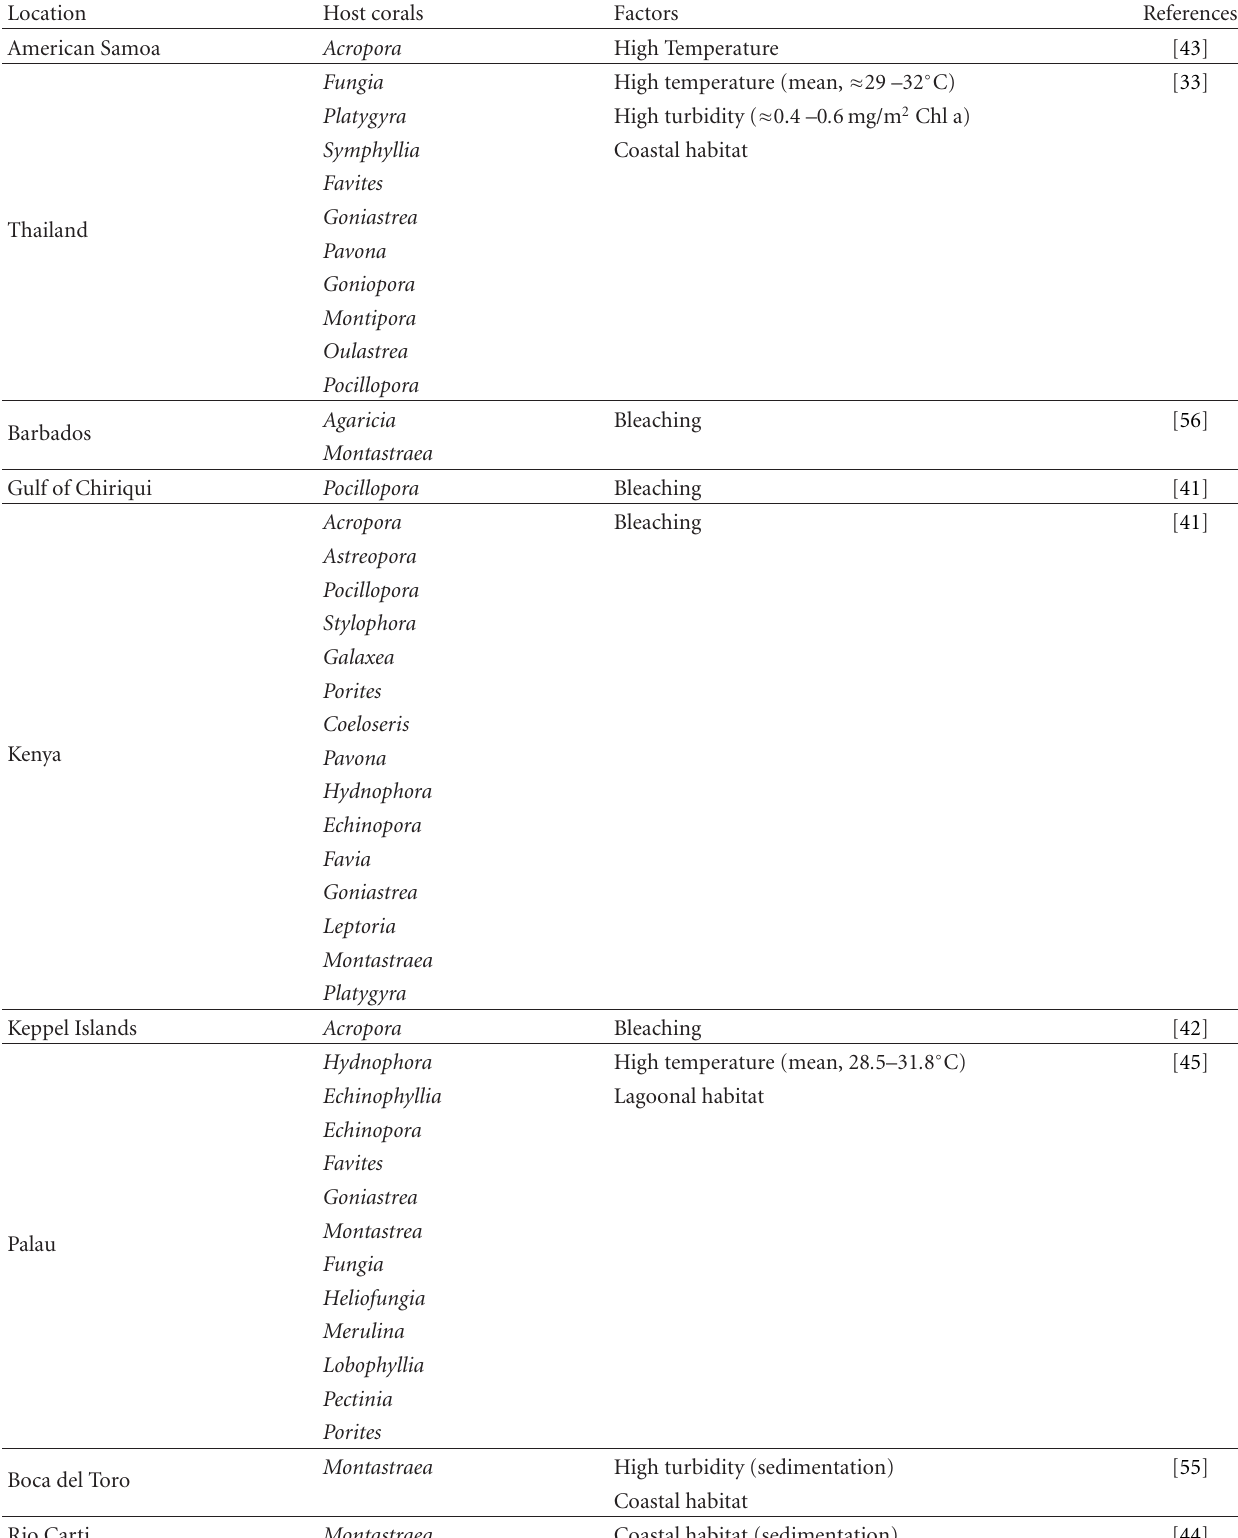
Table 1: Distribution and factors associated with relatively high abundances of Symbiodinium clade D in corals.